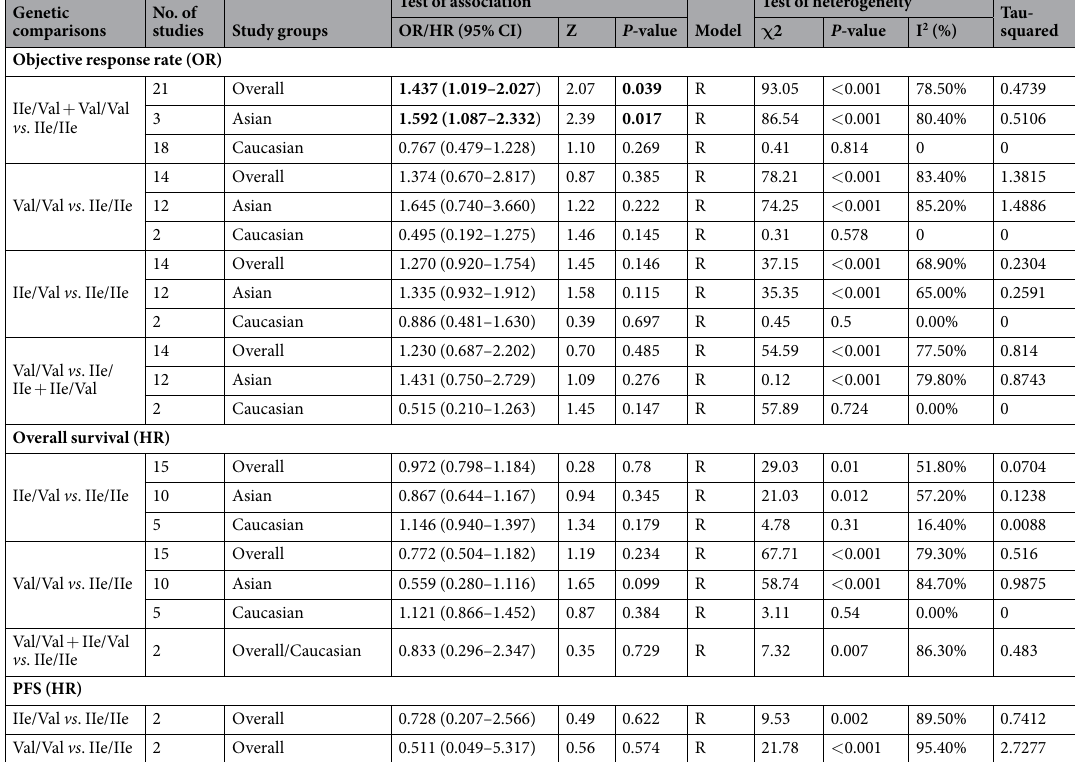
Table 4. Meta-analysis of the association between GSTP1 IIe105Val polymorphism and platinum-based chemotherapy in objective response rate, overall survival and median progression-free survival for NSCLC patients. OR, odds ratio; HR: hazard ratio; CI, confidence interval; vs., versus; F, fixed effect model; R, random effect